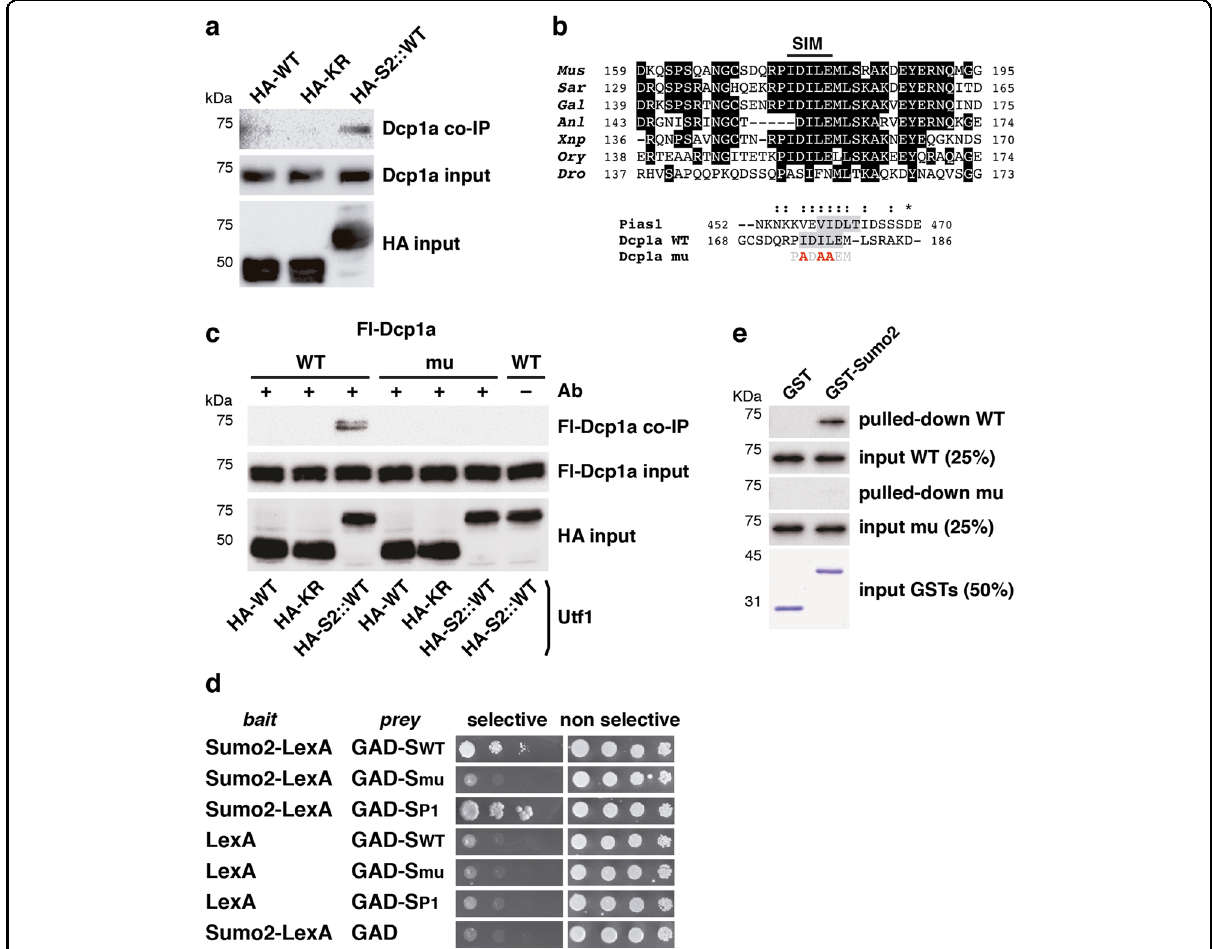
Fig. 6 A conserved SIM in Dcp1a mediates interaction with sumoylated Utf1. a Interaction of endogenous Dcp1a with expressed HA-tagged WT, KR, or an N-terminal Sumo2 fusion of WT Utf1 (HA-S2::WT) was investigated by co-immunoprecipitation with anti-HA antibodies. Inputs (10%) are also shown. b Alignment of Dcp1a sequences from different species corresponding to a region with a predicted SIM (top, residues conserved in four out of the seven sequences have been boxed in black), and alignment of the mouse Dcp1a WT SIM with the mouse Pias1 SIM (gray shadow), indicating mutations (red) introduced in Dcp1a to disrupt the SIM (Dcp1a mu) (bottom). Similar and identical residues are marked with : and *, respectively. Protein accession numbers: Mus , Mus musculus (NP_598522.3); Sar , Sarcophilus harrisii (XP_012399256.2); Gal , Gallus gallus (XP_004944623.1); Anl , Anolis carolinensis (XP_008103449.1); Xnp , Xenopus laevis (XP_018096411.1); Ory , Oryzias latipes (XP_011475154.1); Dro , Drosophila melanogaster (NP_611842.1); Pias1, Mus musculus (XP_006511365.1). c Interaction of Flag (Fl)-tagged Dcp1a, wild type, or mutated in the SIM, with HA-tagged WT, KR, or an N-terminal Sumo2 fusion of WT Utf1 (HA-S2::WT) was investigated by co-immunoprecipitation with anti-HA antibodies. Inputs (10%) are also shown. d Two-hybrid assay to probe interaction between Sumo2 fused to the LexA DNA-binding domain (LexA) bait protein and WT (SWT) or mutant (Smu) version of the Dcp1a SIM or the Pias1 SIM (SP1) fused to the GAL4 activation domain (GAD) prey proteins. Interaction, as determined by yeast growth, was assessed both in selective and non-selective media. e Flag-tagged wild-type (WT) or SIM mutant Dcp1a-puri fi ed proteins were incubated with GST or a GST-Sumo2 fusion protein. Pulled-down products and the corresponding input were revealed by western blot. GST proteins were revealed by Coomassie Blue